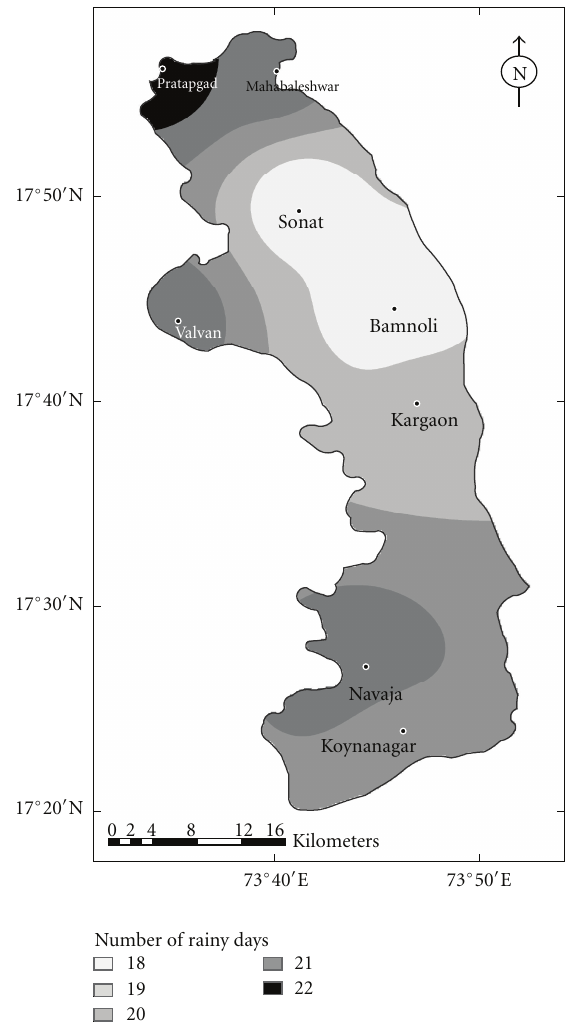
Figure 12: Spatial distribution of rainy days over the Koyna catch-